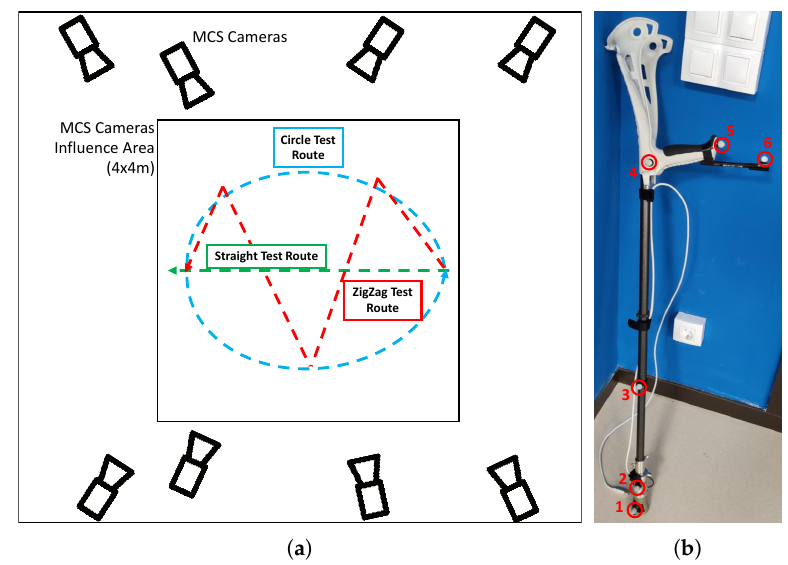
Figure 3. ( a ) 3D Motion Capture Laboratory Schematic with camera placements, capture area and defined test trajectories. ( b ) Reflective marker distribution on the tested crutch (the markers are identified with numbers).